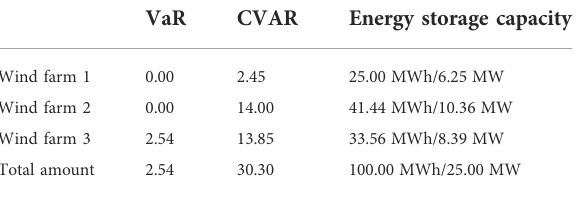
FIGURE 8 The remaining power of energy storage allocated to wind farm